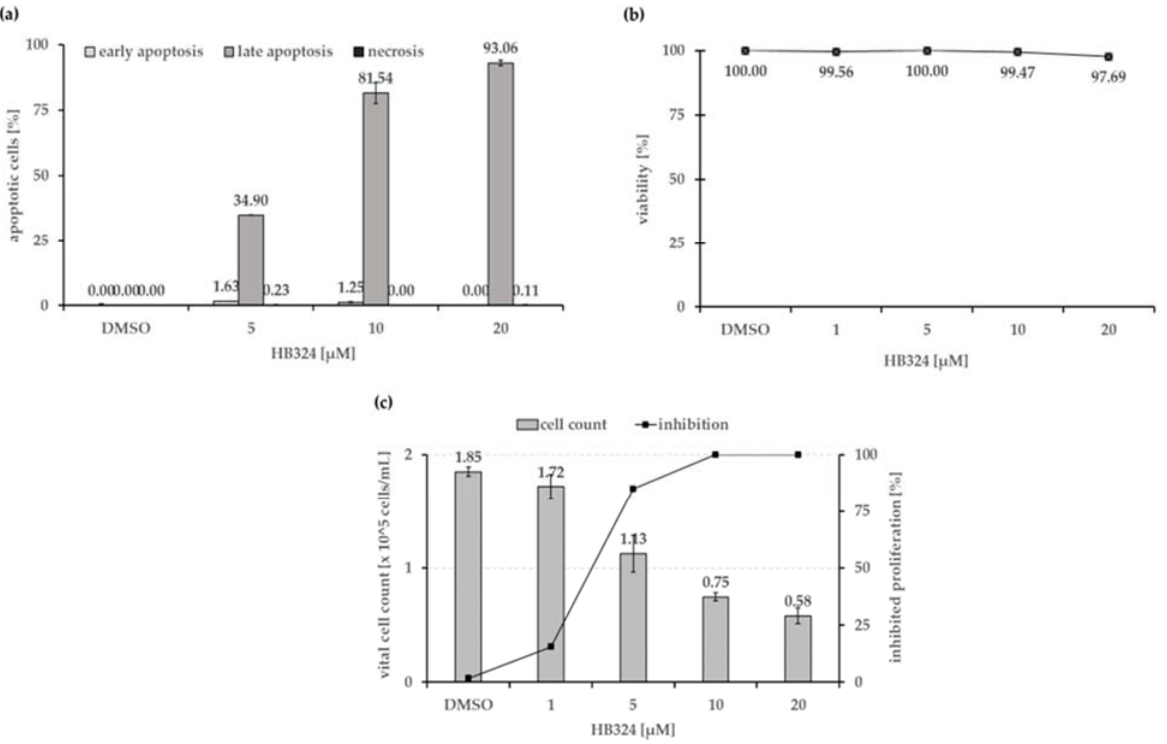
Figure 2. ( a ) Nalm-6 cells were treated and incubated with increasing concentrations of HB324 for 48 h. Solvent treated cells (0.5% dimethyl sulfoxide (DMSO)) served as the control. Distribution of counted cells according to cell status was measured by flow cytometric analysis. Vital cells, representing the remaining fraction, are not shown. Depicted values are mean values ± SD (n = 3). ( b ) To exclude unspecific, cytotoxic effects as necrotic cell death, the viability of Nalm-6 cells was determined by measurement of LDH release into the medium after 1 h of incubation with different concentrations of the compound. A proportion of cells were treated with 0.5% DMSO as the solvent control. Values are given as % of control ± SD (n = 3). ( c ) Nalm-6 cells were seeded at a density of 1 × 10 5 cells/mL, and proliferation was measured after 24 h of incubation with the complex using the CASY ® CellCounter and Analyzer System. Solvent treated cells (0.5% DMSO) served as the control. Inhibition of proliferation is given in % of control as mean values ± SD (n = 3).